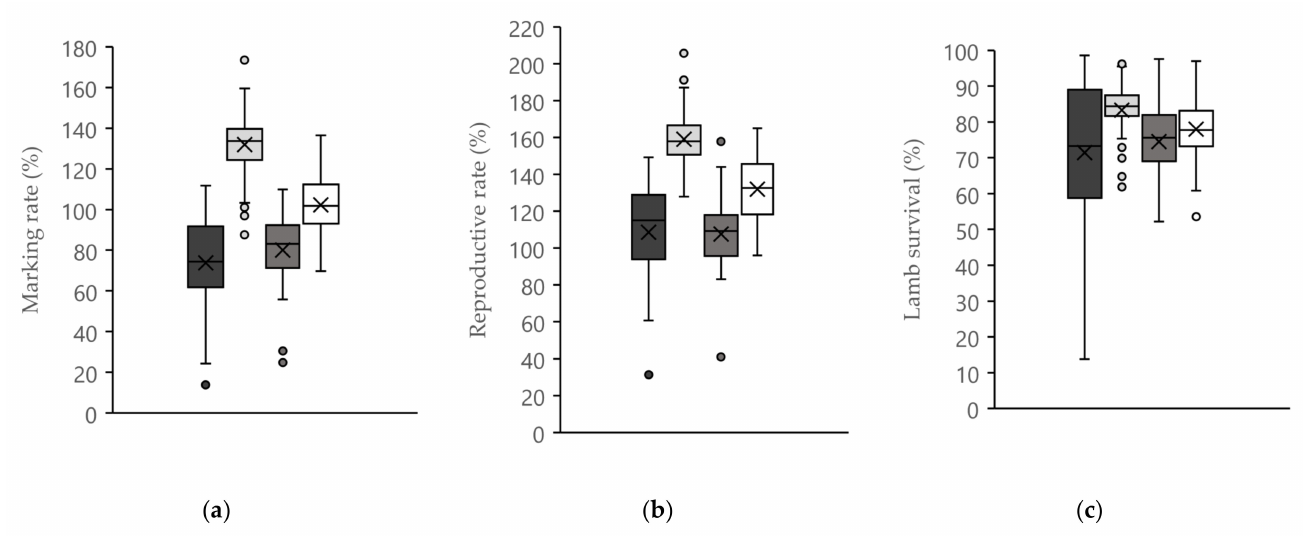
Figure 1. Box and whisker plot for ( a ) marking rate, ( b ) reproductive rate and ( c ) lamb survival in maiden ewe lambs, Merino two-tooth ewes and equivalent multiparous ewes. Maiden non-Merino ewe lambs. Multiparous non-Merino ewes. Maiden Merino two-tooth ewes. Multiparous Merino ewes.